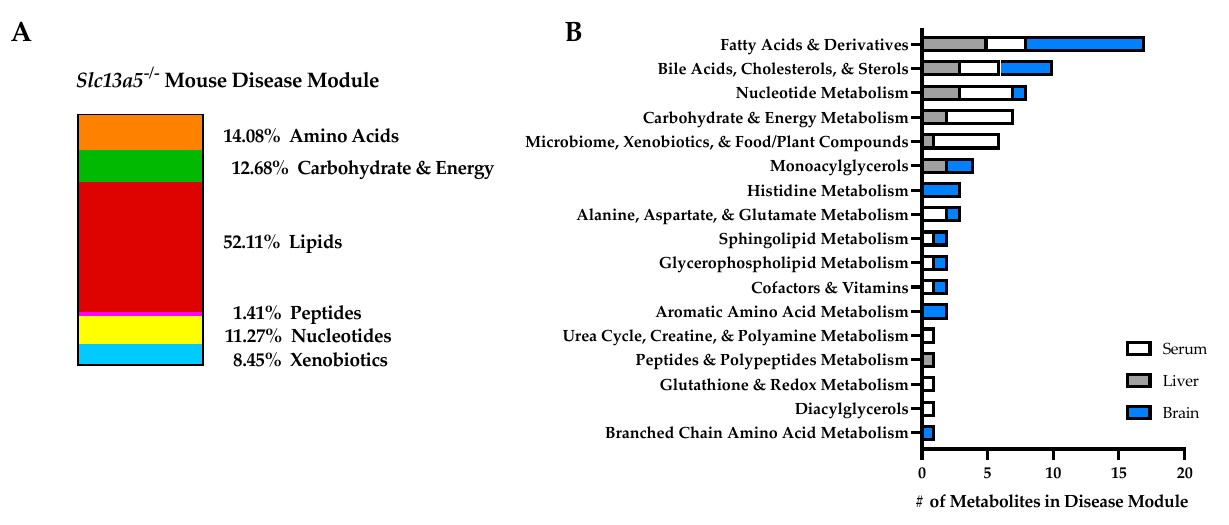
Figure 2. Slc13a5 deficiency mouse model disease modules determined by CTD. CTD analysis identified the most perturbed metabolites in tissues from Slc13a5 − / − mice as compared to wildtype mice for each tissue tested: serum (WT, n = 10; KO, n = 9), liver (WT, n = 10; KO, n = 10), or brain (WT, n = 10; KO, n = 9). Pathways within which perturbed metabolite falls are shown to provide a more meaningful analysis than simply listing individual metabolites. ( A ) CTD analysis represented in an enrichment of the super pathways for the key metabolites in the CTD network. Pathway enrichment of the CTD networks for the 71 CTD-identified metabolites identified in the brain ( n = 26), serum ( n = 28), and liver ( n = 17) are illustrated in the major metabolic super pathways, highlighting the >50% lipid composition of these disease modules. ( B ) Sub-pathway enrichment of the CTD network of the most perturbed metabolites and pathways in Slc13a5 deficiency mice are shown for serum, brain, and liver (for tissue metabolite detail, see Supplementary Data, Table S2). # = number or quantity of metabolites